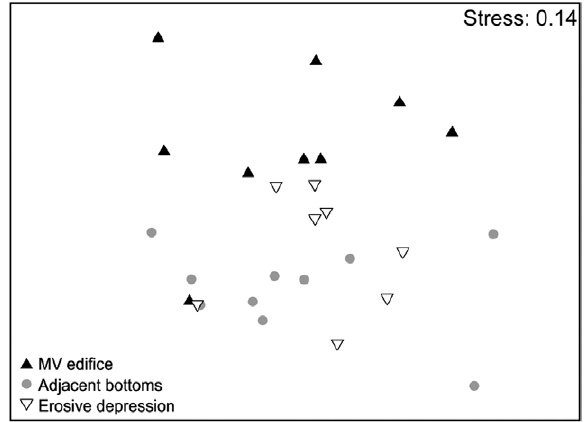
Fig. 2. – Non-metric multidimensional scaling ordination based on qualitative (presence/absence of live-taken species) similarities (Bray-Curtis similarity index) between the molluscan assemblages found in all samples collected in the different areas of the Gazul mud volcano